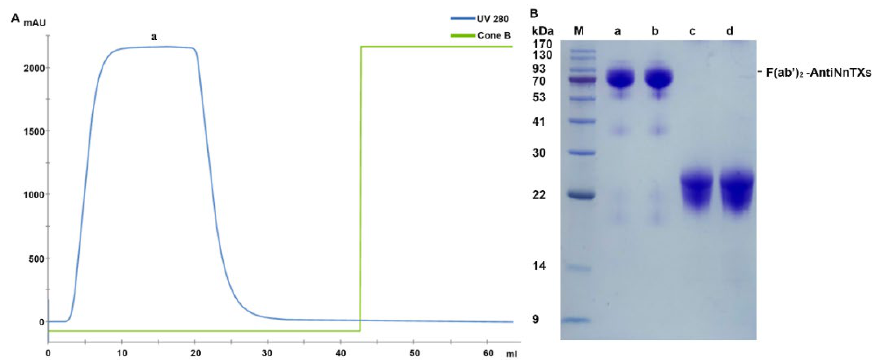
Figure 5. Affinity purification of F(ab’) 2 -AntiNnTXs. ( A ) Protein A purification chromatogram of F(ab’) 2 -AntiNnTXs. ( B ) SDS-PAGE profile of the fractions from the protein A purification. M: marker; a, b, and F(ab’) 2 -AntiNnTXs under the non-reduced condition; c, d, and F(ab’) 2 -AntiNnTXs under the reduced condition.